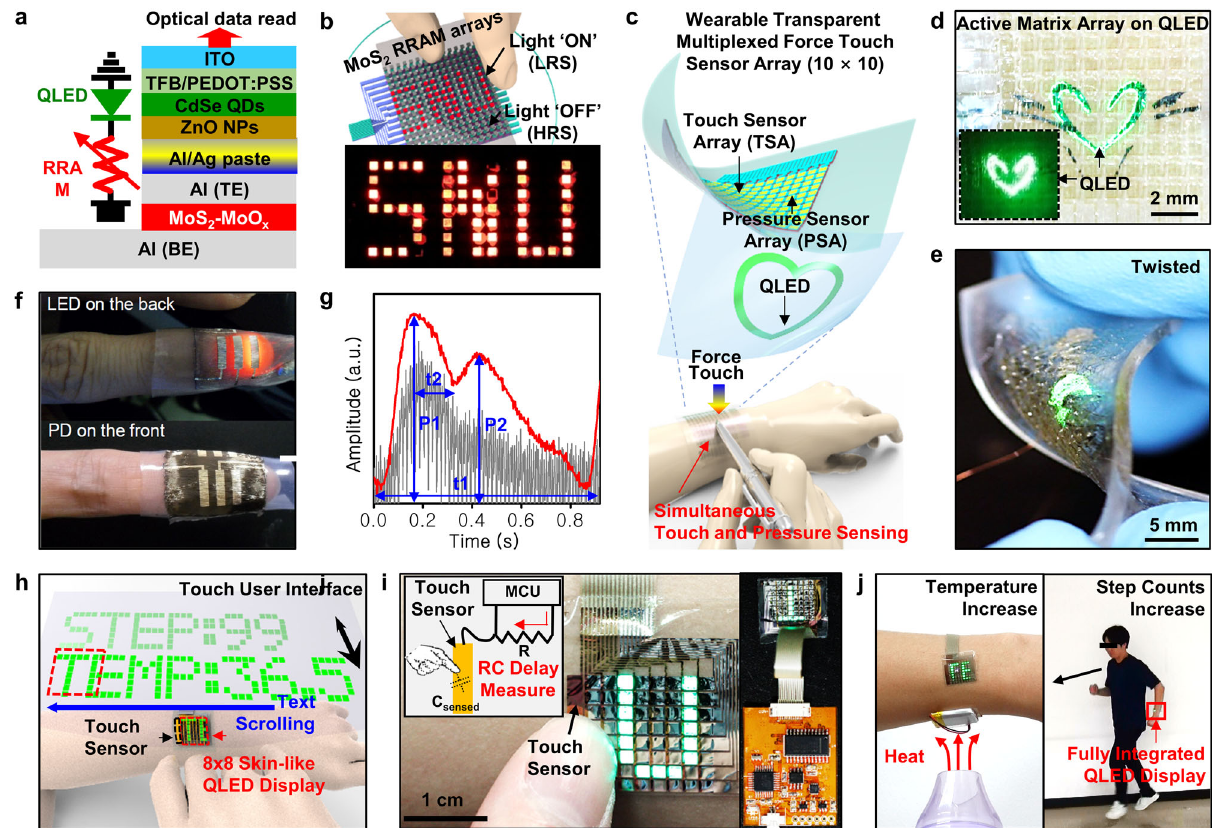
Fig. 8 Wearable QLEDs integrated with other electronic devices. a , b Cross-sectional device structure ( a ) and schematic illustration ( b ) of the QLED display integrated with MoS 2 ReRAM. c , d Schematic representation ( c ) and image ( d ) of transparent and wearable force touch sensor array integrated with a skin-mounted QLED. Inset of ( d ) shows the QLEDs under dark conditions. e Twisted wearable devices on ultrathin QLEDs. f Epidermal PPG sensor composed of QLED and QD PD. g PPG signal from the QD-based epidermal PPG sensor. h , i Schematic illustration ( h ) and photograph ( i ) of the ultrathin QLED display integrated with wearable electronics. Inset of ( i ) shows an illustration of the measurement setup. j Integrated wearable electronic system subjected to external heat (left) and running wearer (right). Skin-mounted QLED shows the measured information. Figure reproduced with permission from: a , b ref. 155 © 2016 Wiley; c – e ref. 156 © 2017 Wiley; f , g ref. 158 © 2017 ACS; h – j ref. 51 © 2017